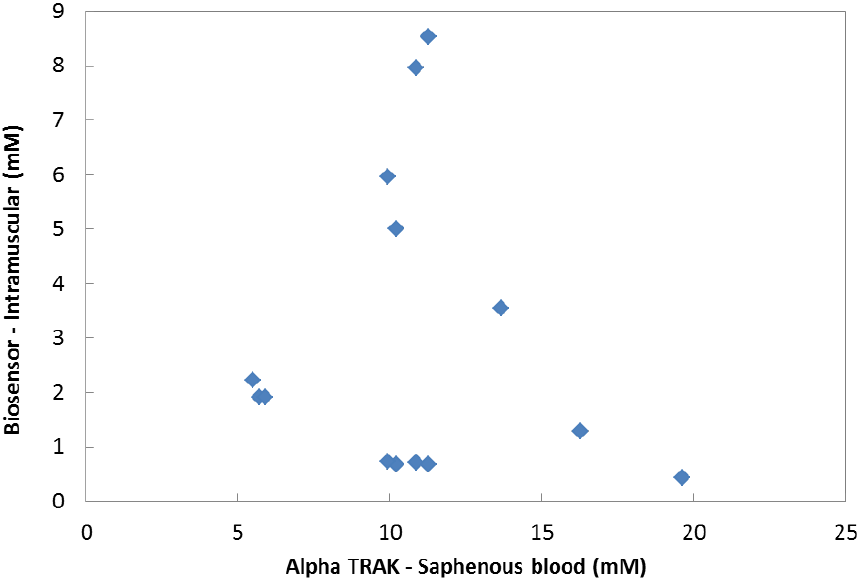
Figure 10. Response comparison of the implanted MDEA 5037 glucose biotransducers with respect to hand-held Alpha TRAK measurement of venous blood glucose as a